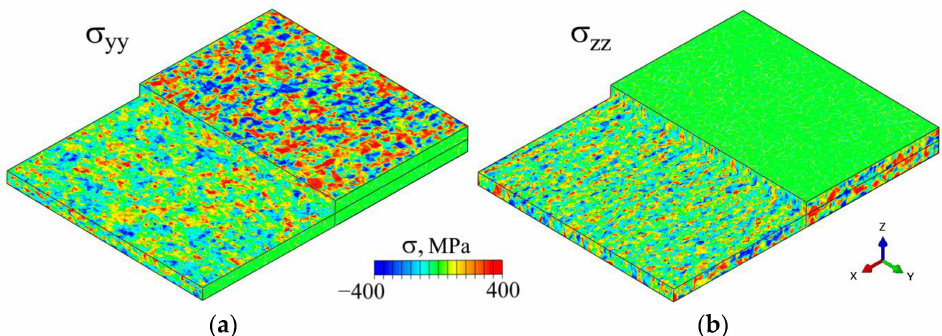
Figure 11. Stress tensor components acting perpendicular to the tensile axis for 0.22% ( a ) and 5% tensile strain ( b